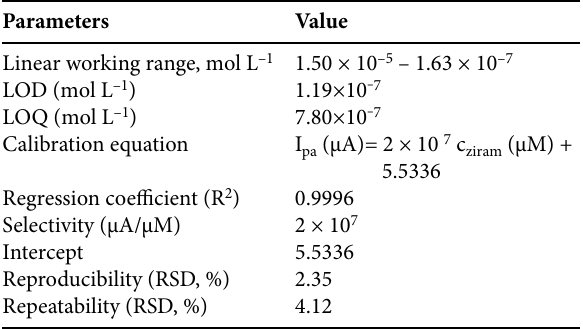
Table 2. Analytical performance of the RGO/AuNPs/GCE sensor for ziram. Parameters Value